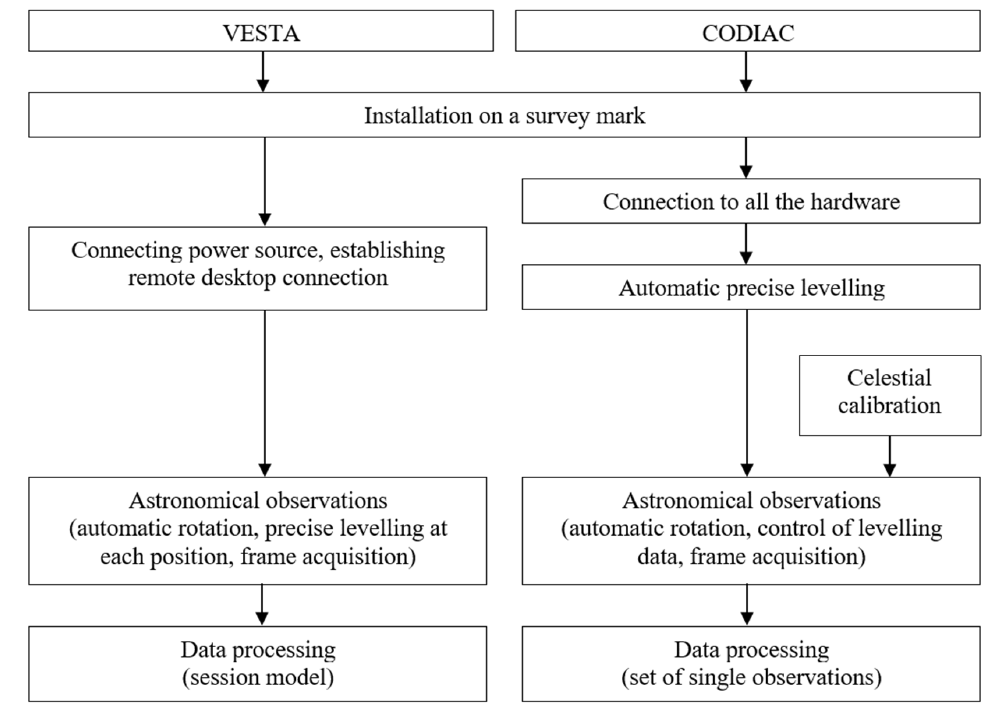
Figure 2. Main observation steps of VESTA and